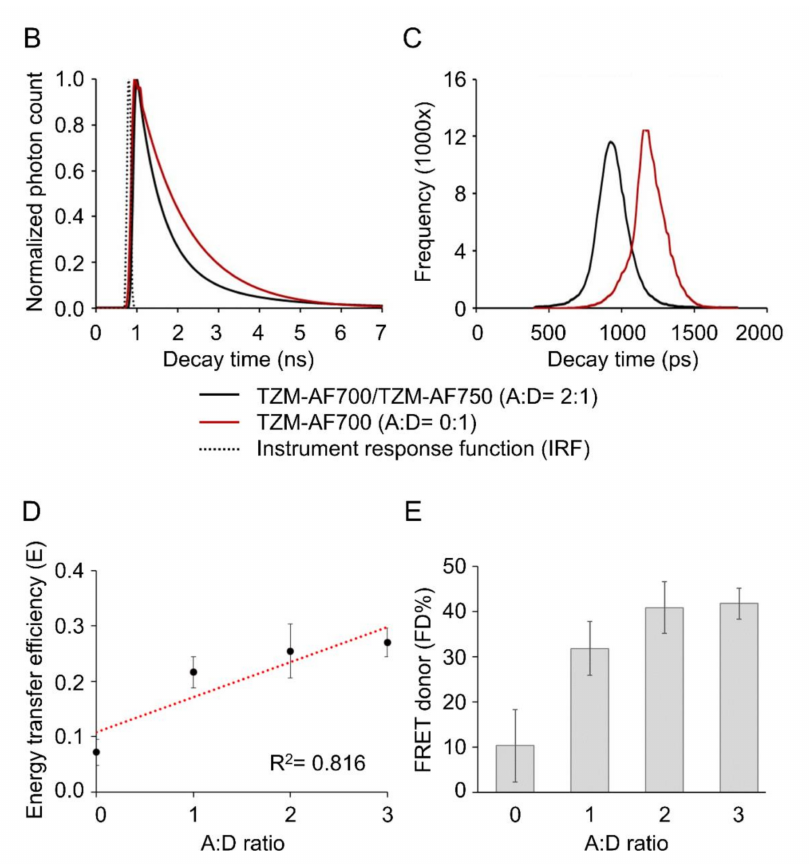
Figure 3. TZM Forster Resonance Energy Transfer (FLI-FRET) microscopy (FLIM-FRET) analysis in AU565 cancer cells. ( A ) The representative time-correlated single photon counting (TCSPC) images of fluorescence intensity and mean lifetime map ( τ m ) in cells treated with TZM-AF700 only [Acceptor / Donor (A:D) = 0:1; donor single-labeled] or with TZM–AF700 plus TZM–AF750 (A:D = 2:1; double-labeled); pseudo-color range = 500–1500 ps. Zoomed regions of interest (ROIs) of both single and double-labeled cells show heterogeneity of fluorescence lifetime of TZM–AF700 within the cells. White arrows indicate x, y coordinates used for the curve fitting using SPCImage. Scale bar = 50 µ m. ( B ) Representative fitting curves and IRF, the fluorescent lifetime decay in the single and double-labeled cells was determined by comparing the fitting of the decay data using both single- and double-exponential decay models, respectively. ( C ) Fluorescent lifetime distribution in AU565 cells treated with TZM–AF700 (A:D = 0:1) or TZM–AF700 and TZM–AF750 (A:D = 2:1). ( D ) Quantification of FRET donor (FD%) levels in AU565 cells treated with a near-infrared (NIR) TZM–FRET pair at various A:D ratios. Analysis was performed using 10 distinct pixel coordinates ( n = 10) from five independent ROIs; error bars represent confidence interval at 95%. ( E ) Quantification of TZM–FRET e ffi ciency (E) in relation to A:D ratios. Data presented as mean ± confidence interval at 95%, n =